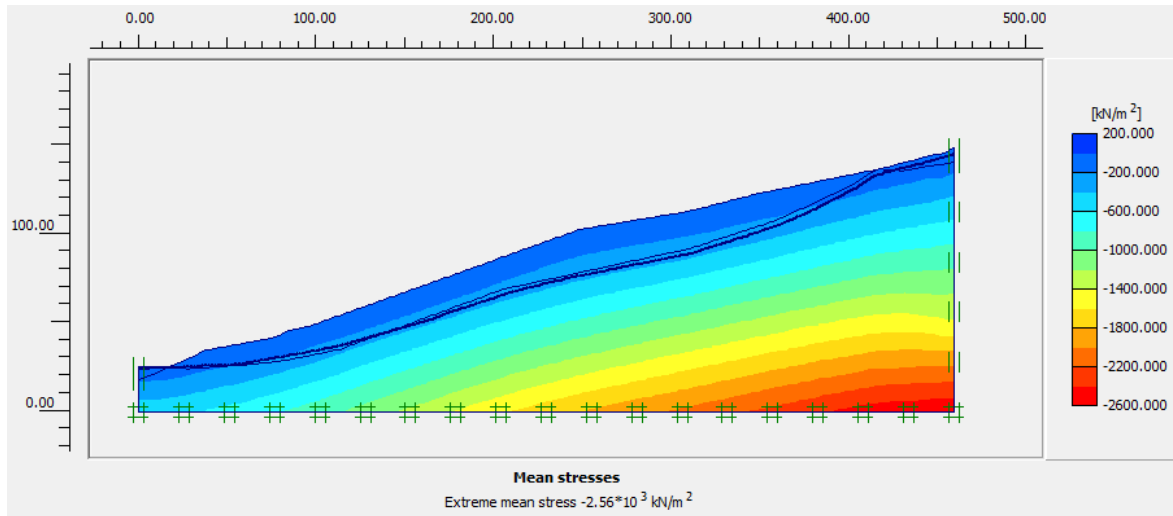
Fig. 6. The contour of initial stresses in the PLAXIS model using gravity loading